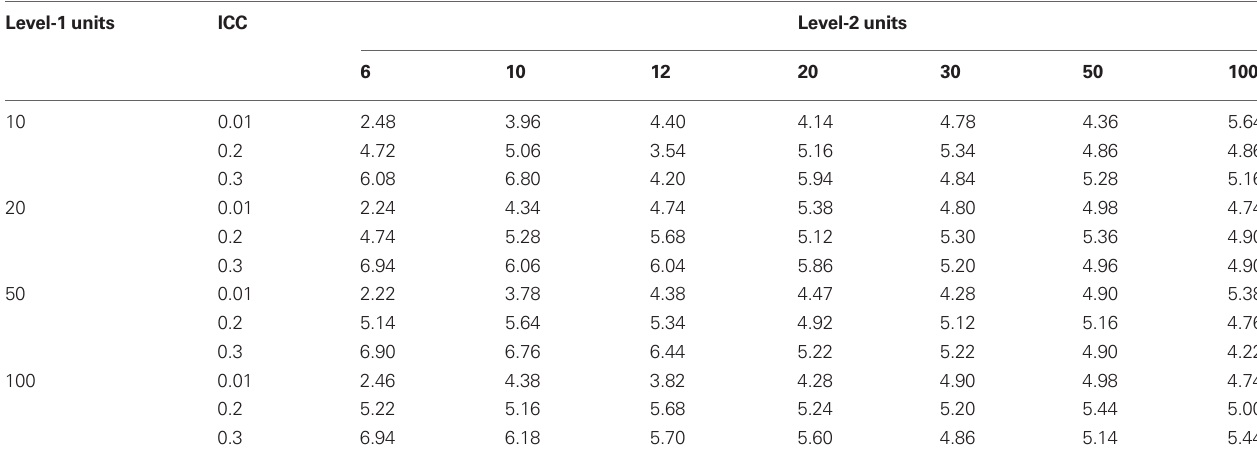
Table 2 | Kish-corrected Type-I error percentage as a function of ICC value and of the number of level-1 units (rows) and the number of level-2 units